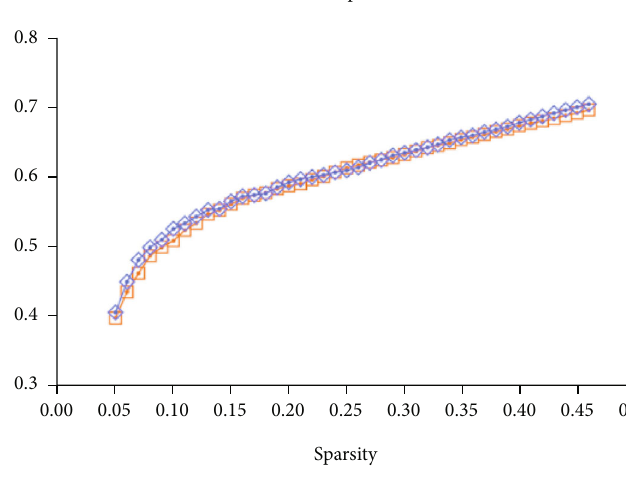
) and characteristic path length (L ) in the lumbar disc herniation p p